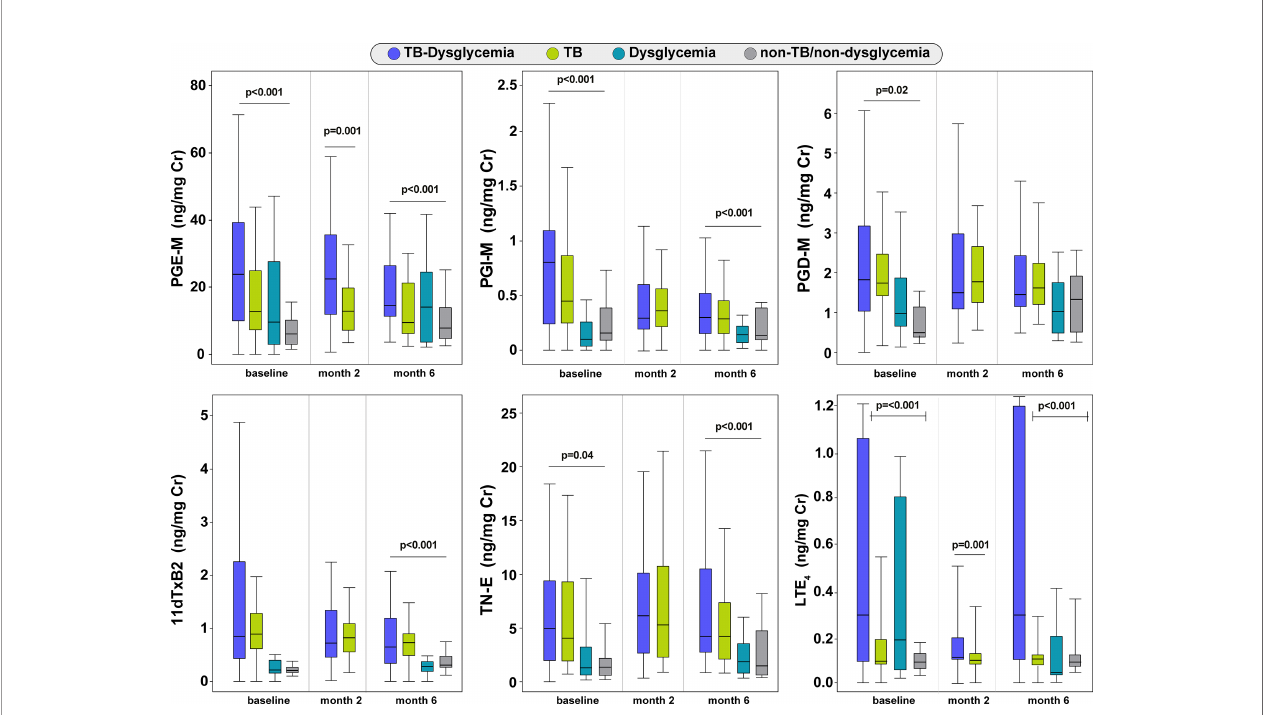
FIGURE 1 | Comparison of the distribution of urinary eicosanoids between the study groups. Box plot depicting the distribution of eicosanoids (median and interquartile range) among TB-dysglycemia, TB, dysglycemic patients and non-TB/non-dysglycemia individuals at each timepoint. Groups were compared using Kruskal Wallis (for four groups) and Mann Whitney tests (for two groups). Individuals without TB (Dysglycemia and non-TB/non-dysglycemia groups) had only two visits (baseline and month 6). TB, tuberculosis; PGE-M, major urinary PGE 2 metabolite; PGD-M, major urinary PGD 2 metabolite; PGI-M, 2,3-dinor-6-keto-PGF 1 a (PGI 2 Metabolite); 11dTxB2, 11-dehydro-thromboxane B 2 (TxB 2 urinary metabolite); TN-E, tetranor-PGE 1 (urinary PGE 2 metabolite); LTE 4 , Leukotriene E 4